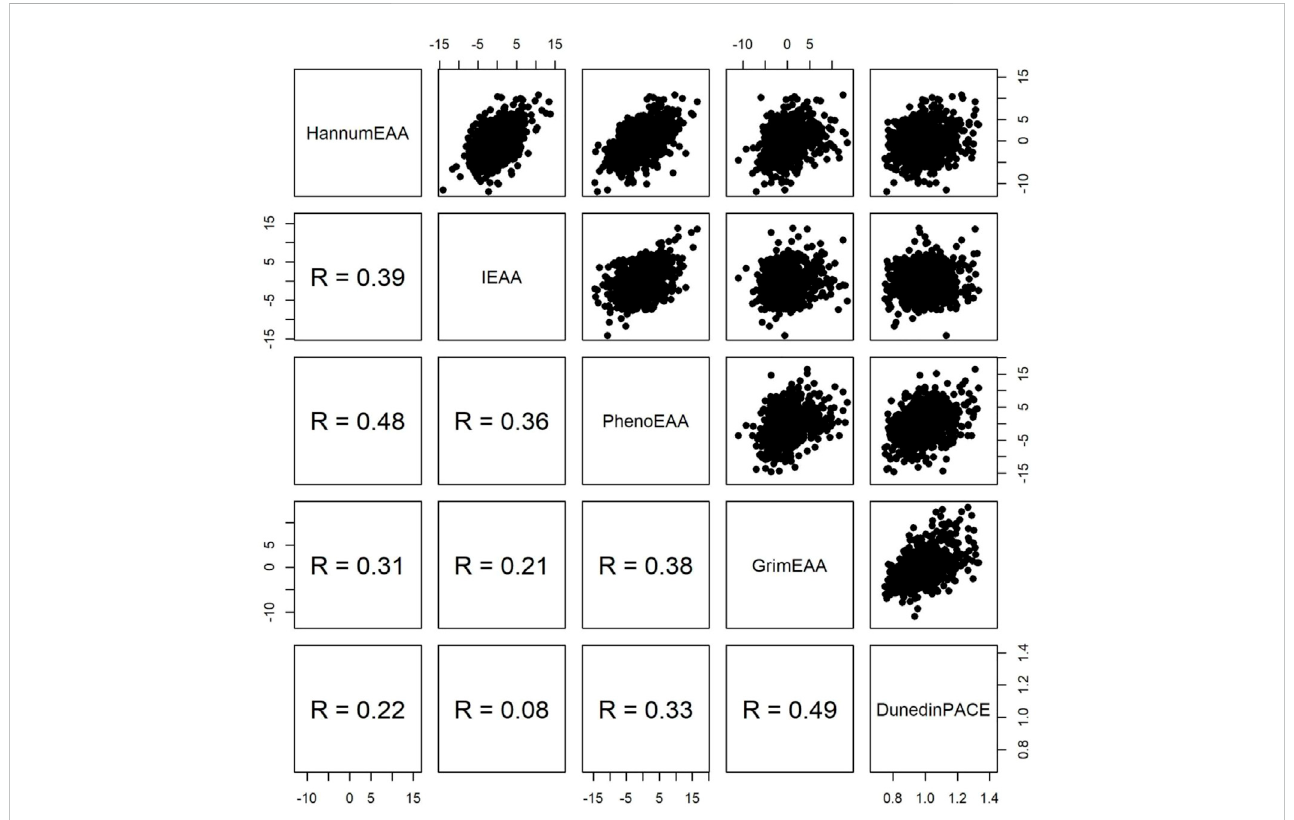
FIGURE 2 Pairwise scatter plots of four measures of epigenetic age acceleration and DunedinPACE. R represents Spearman ’ s rank correlation coef fi cient.